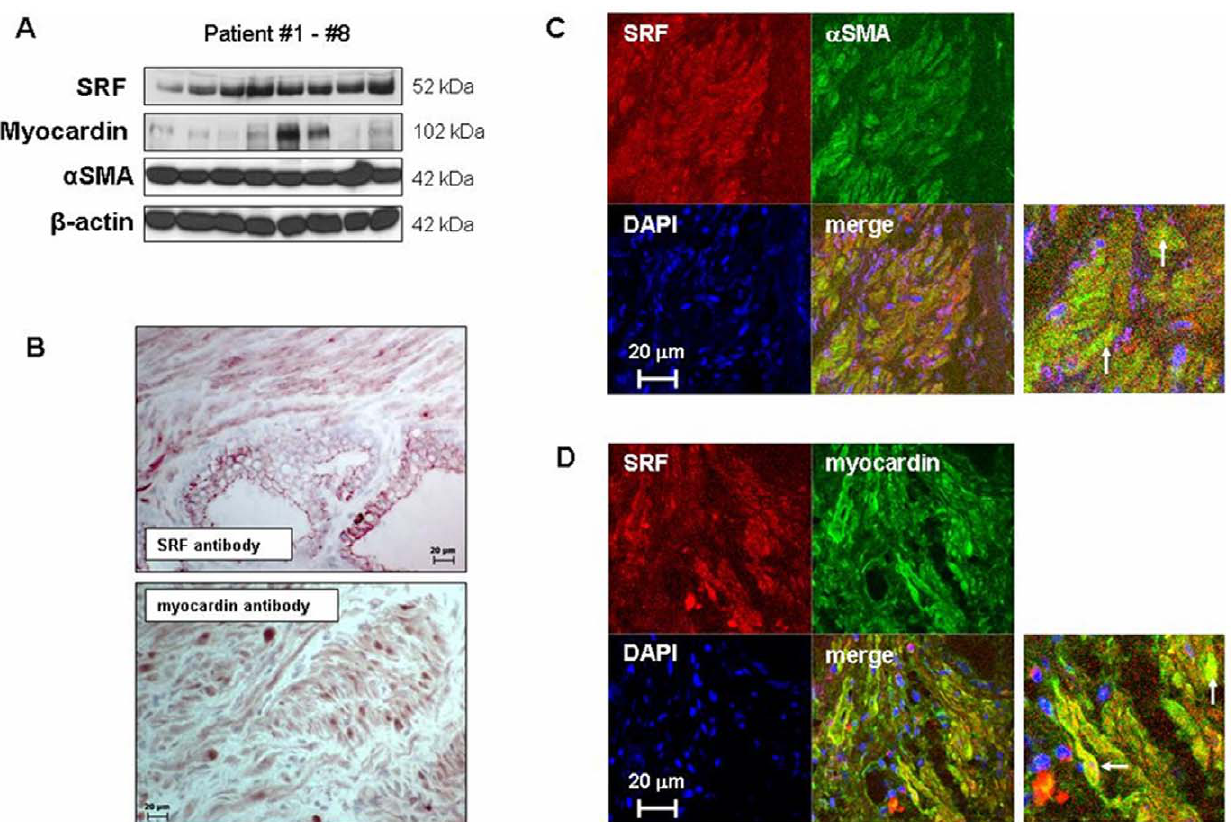
Figure 2. SRF and myocardin expression in human prostate tissue. ( A ) Western blot analyses with prostate tissues from n=8 patients, showing the expression of SRF, myocardin, a SMA, and b -actin. ( B ) Peroxidase staining of prostate tissues for SRF and myocardin (representative stainings of tissues from n=6 patients). ( C ) Double fluorescence staining of prostate tissues for SRF and a SMA (representative stainings of tissues from n=6 patients). Yellow color in merged pictures represents SRF expression in smooth muscle cells. ( D ) Double fluorescence staining of prostate tissues for SRF and myocardin (representative stainings of tissues from n=6 patients). Yellow color in merged pictures represents colocalization of SRF and myocardin). In ( C ) and ( D ), examples for colocalization are indicated by